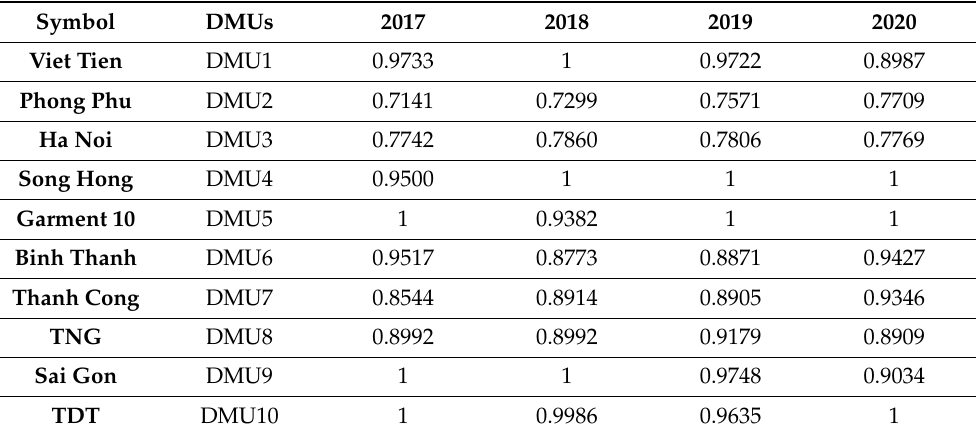
Table 16. Efficiency scores of EBM model from 2017 to